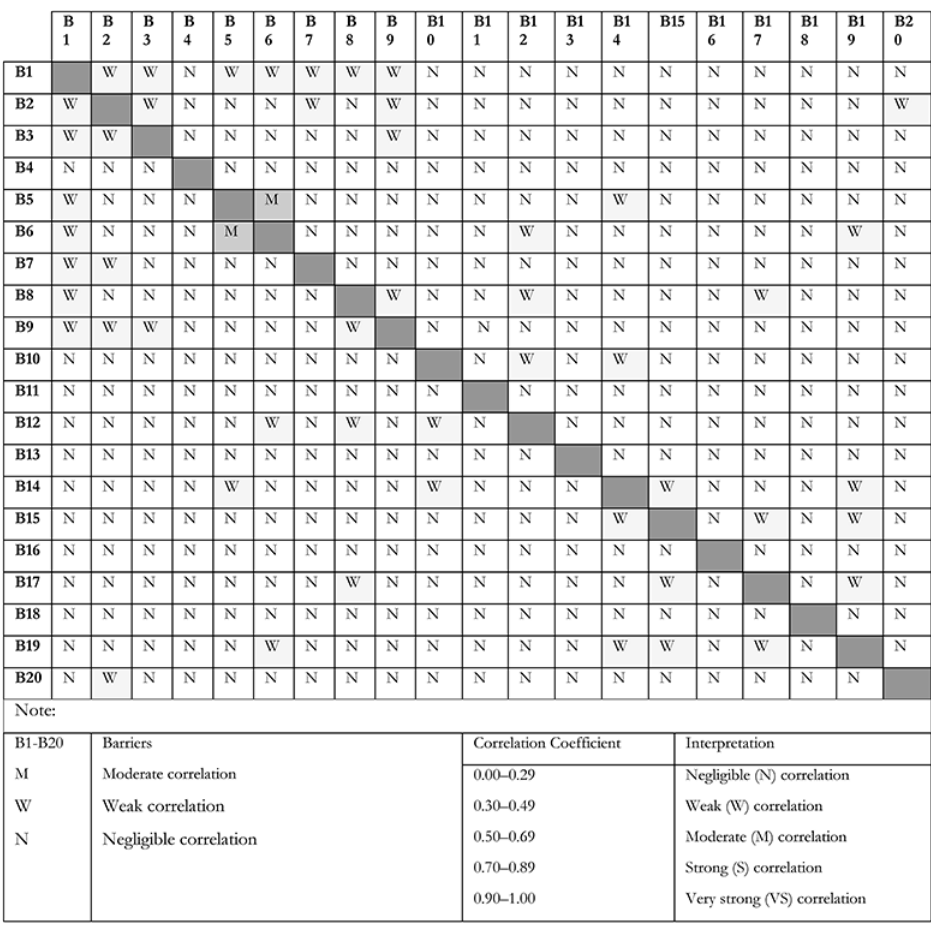
Spearman’s correlation coefficient